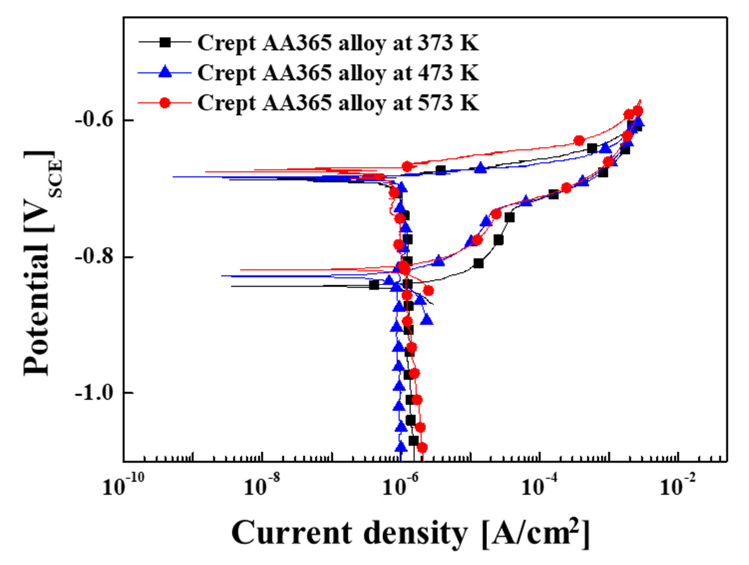
Figure 3. Variation of the open circuit potential (OCP) of crept AA365 alloys in 3.5 wt.% NaCl during a hour of immersion: ( a ) crept AA365 alloy at 373 K; ( b ) crept AA365 alloy at 473 K; ( c ) crept AA365 alloy at 573 K .